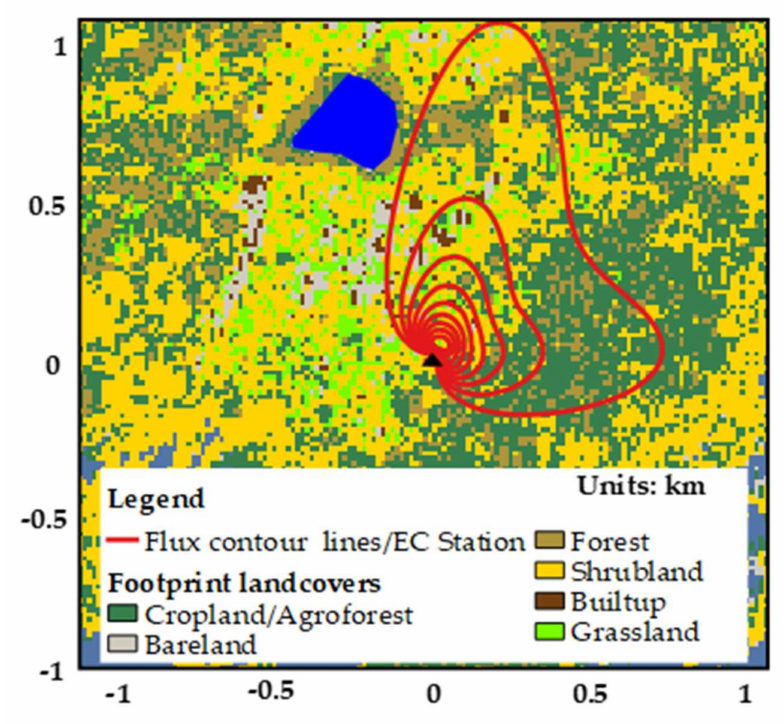
Figure 4. Footprint climatology for the Kayoro flux tower, Tono catchment, Navrongo, Ghana, 17–26 December